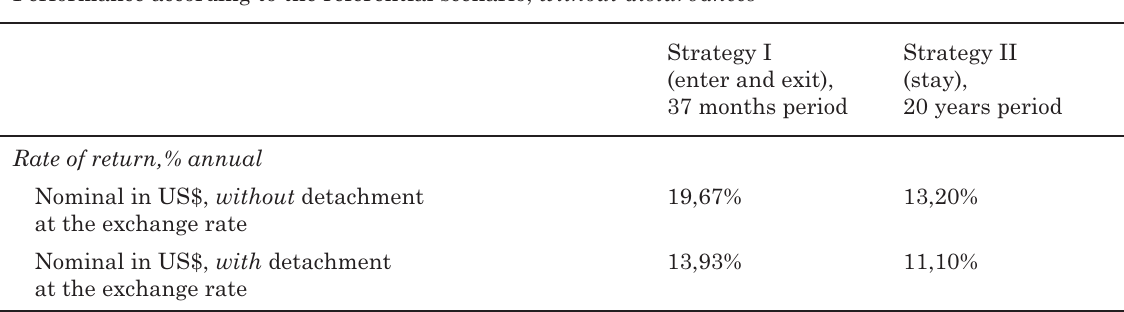
Table 5. Investment quality indicators – rate of return according to different strategies Performance according to the referential scenario, without disturbances